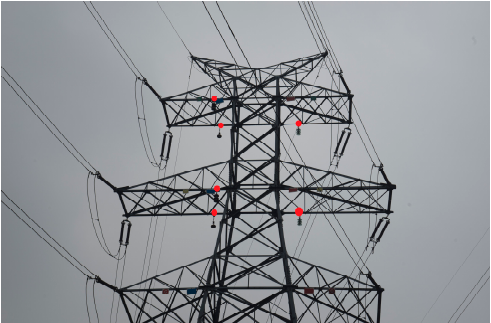
Figure 1. Layout of experimental point (in 500 kV transmission tower). Table 1. Main parameters and profile of insulator tested.